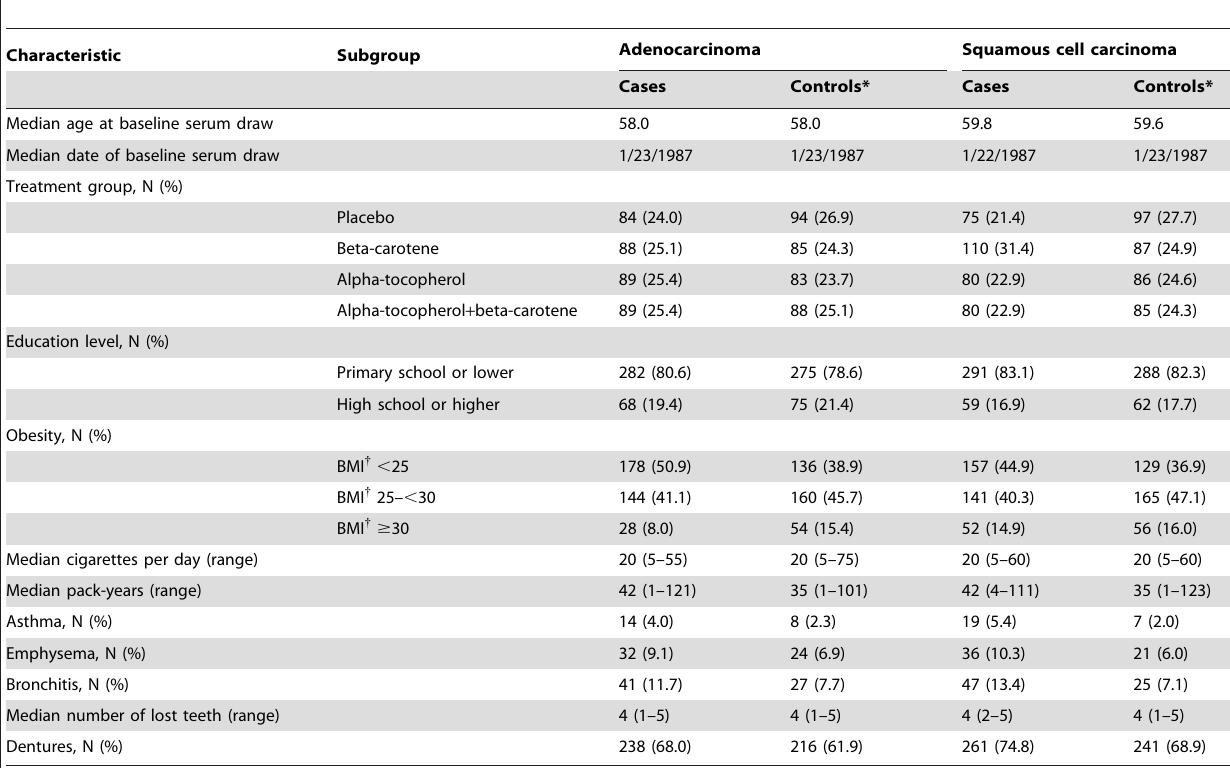
Table 1. Characteristics of randomly selected lung adenocarcinoma and squamous cell carcinoma cases and matched cancer-free controls from the Alpha-Tocopherol, Beta-Carotene Cancer Prevention Study.